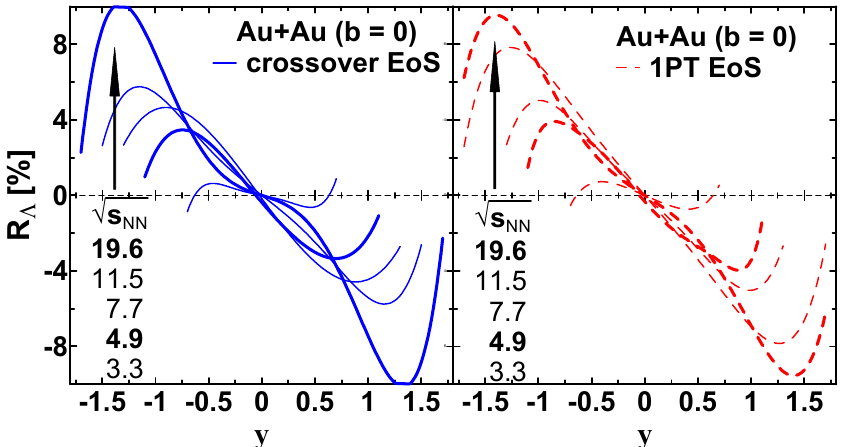
Figure 7. Rapidity dependence of the R Λ quantity in the ultra-central ( b = 0) Au+Au collisions at √ s NN = 3.3–19.6 GeV (upwards at y ≈ − 1). Distributions at 4.9 and 19.6 GeV are indicated by bold lines. Calculations are performed with the crossover ( left panel) and 1PT ( right panel)